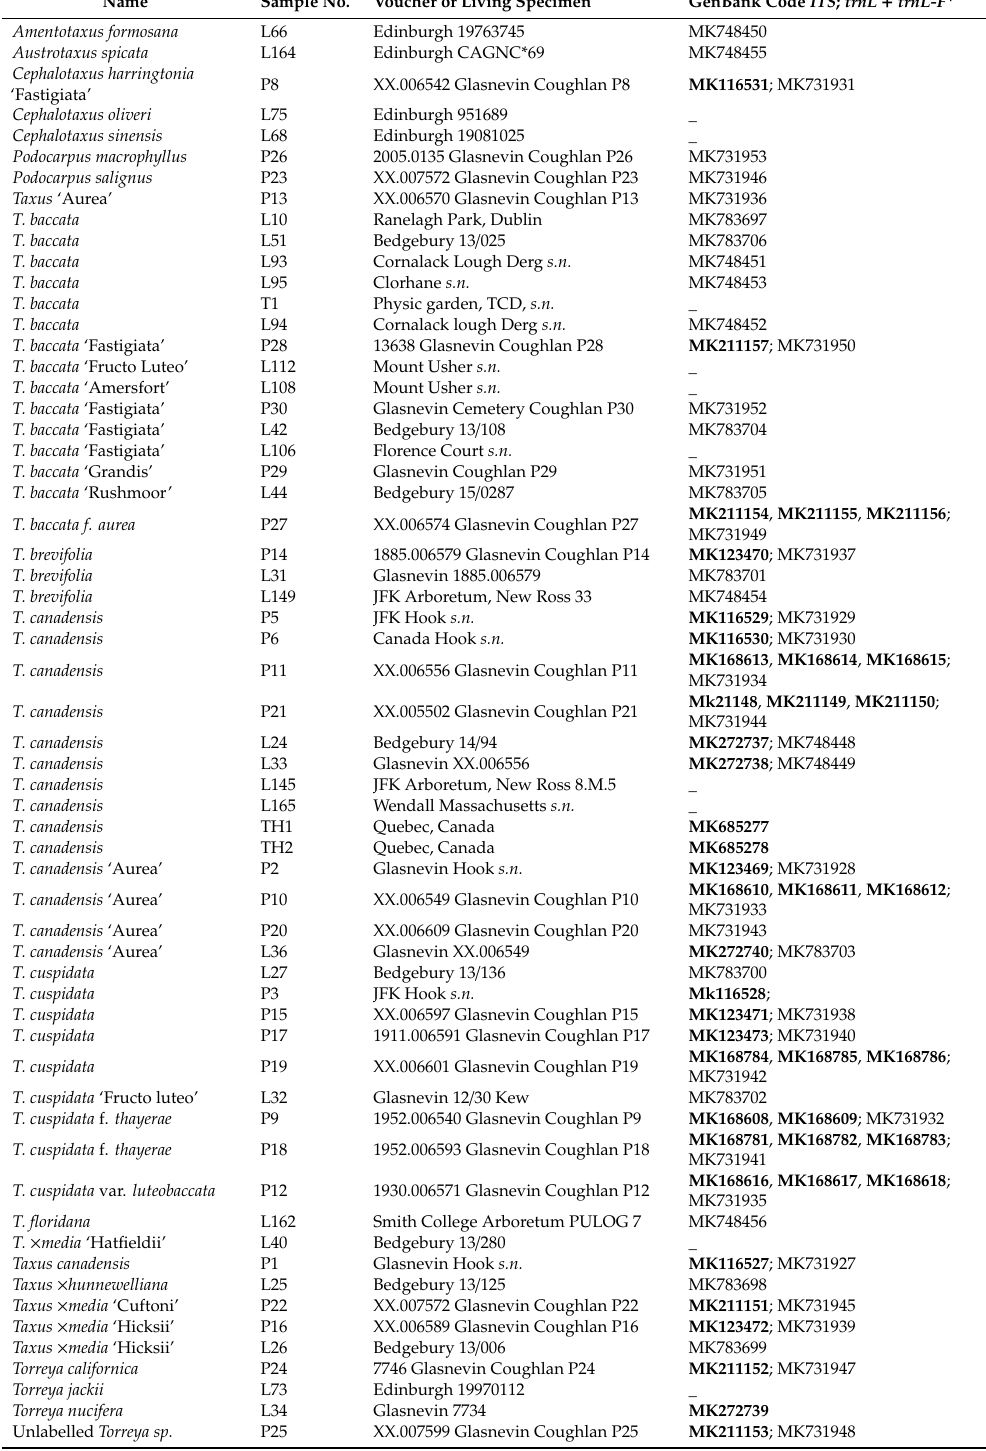
Table 1. Samples newly sequenced for nrITS and trnL intron and trnL-F intergenic spacer or used in the morphological